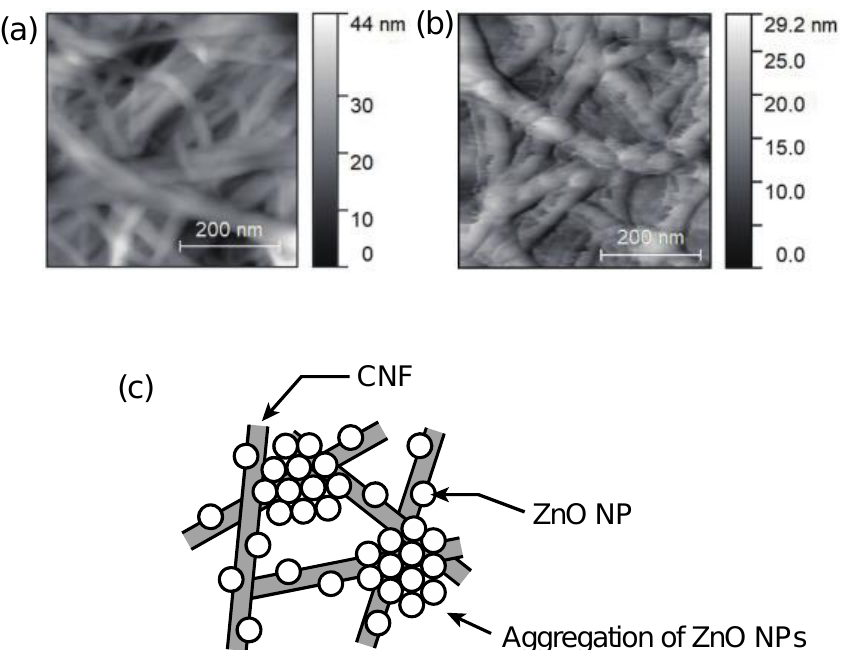
Figure 3. AFM image of ( a ) CNF film without ZnO NPs and ( b ) nanocomposite film with 40 wt.% ZnO. ( c ) Schematic illustration of the conceivable local structure of our film.